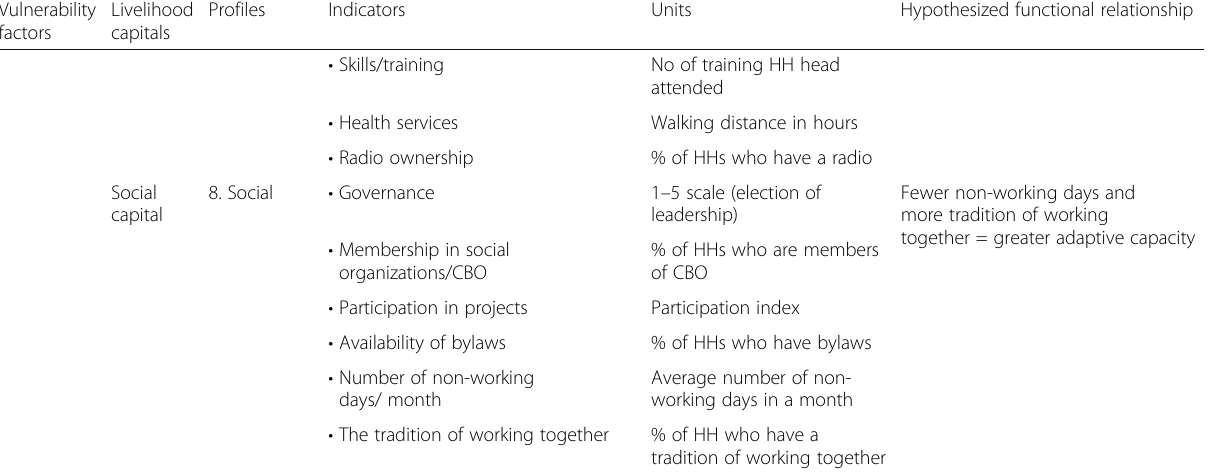
Table 1 Vulnerability factors, livelihood capitals, profiles, and indicators used for LVI analysis using the IPCC framework